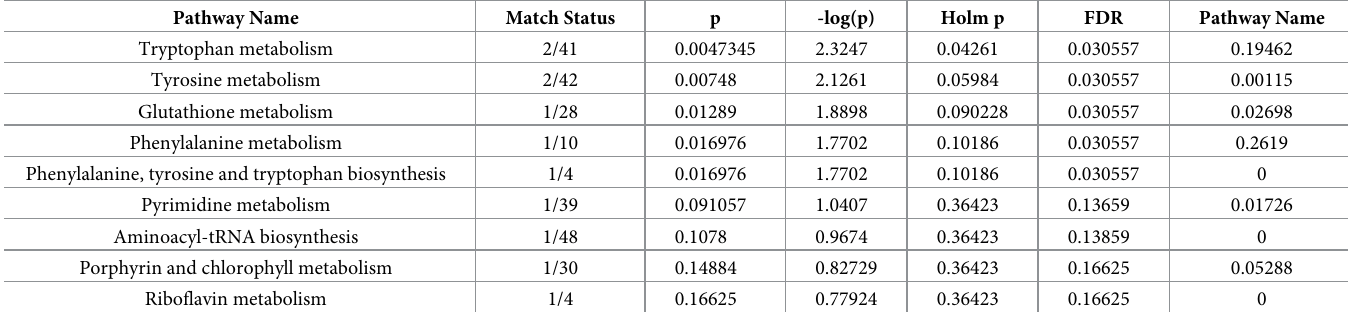
Table 3. Result from pathway analysis by metaboanalyst5.0.